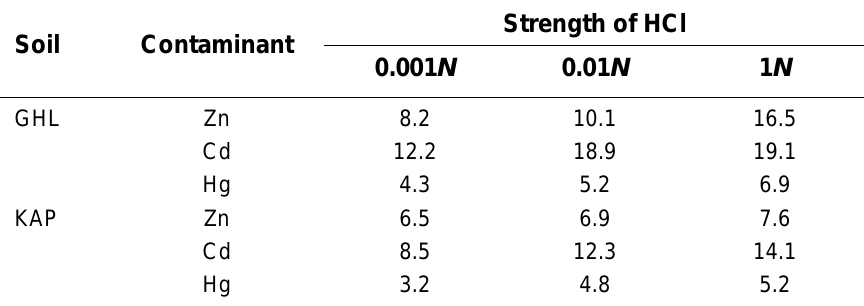
Strength of HCl